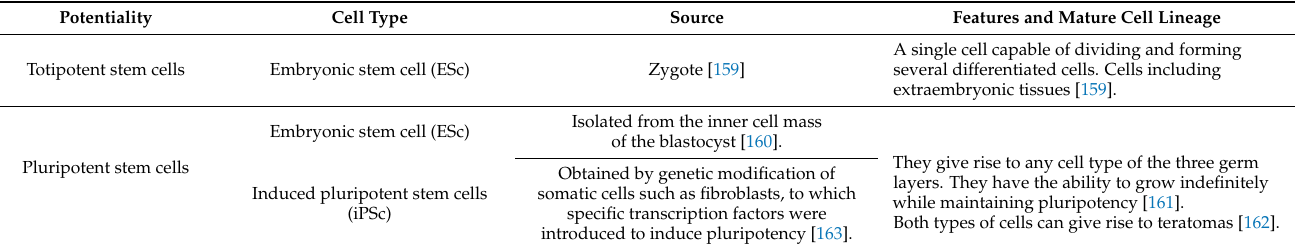
Table 3. Classification of stem cells according to their